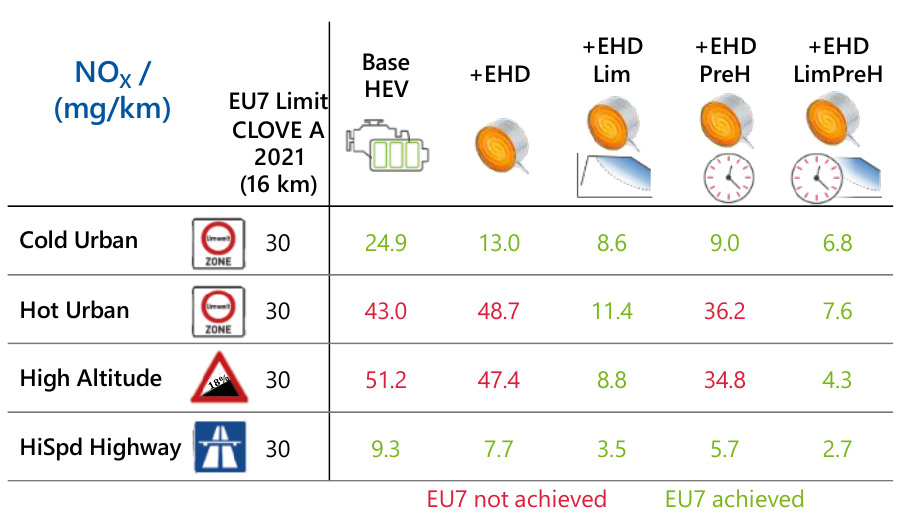
Figure 11. Start of the High Altitude cycle with HEV and EHD. The cycle is characterized by an acceleration with high ICE load demand up to BMEP = 12 bar, starting from t = 8 s. The electrical heating does not increase the temperature fast enough to effectively heat up the exhaust gas and TWC. The benefit of adding an EHD is therefore minor. In the case of an even earlier or more intense acceleration, the EHD can also increase tailpipe emissions, as the additional thermal inertia of the disk slows the heat-up of the catalyst. This is the case for the Hot Urban cycle. To exploit the full potential of the EHD, the heating needs to be operated for some time before a high raw emission mass flow. This is possible by either operating the EHD before the ICE start (pre-heating) or by limiting the ICE power and thus the incoming raw emission mass flow. Both options are combined with the EHD in Figure 12.